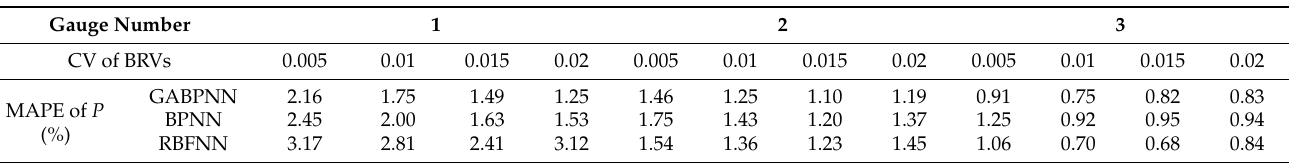
Table 7. The comparison of the test results of the ANNs in the DPR study under the shock load condition where v is 1050